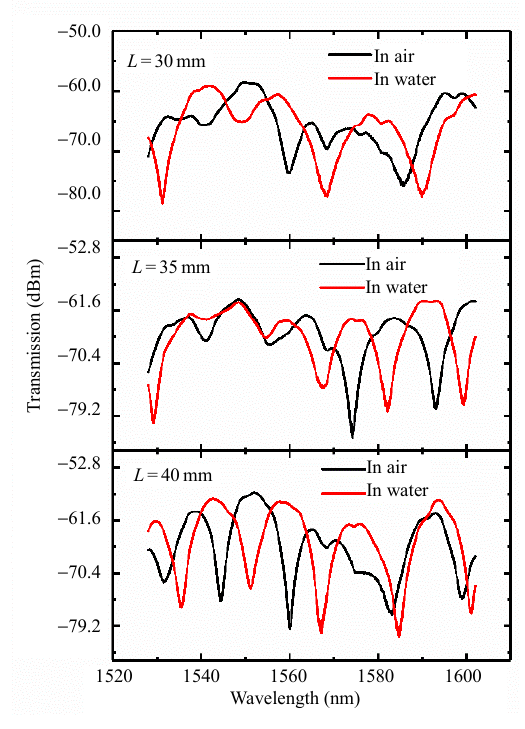
Fig. 3 Transmission spectra of a PCF interferometer with different sensing lengths in air and